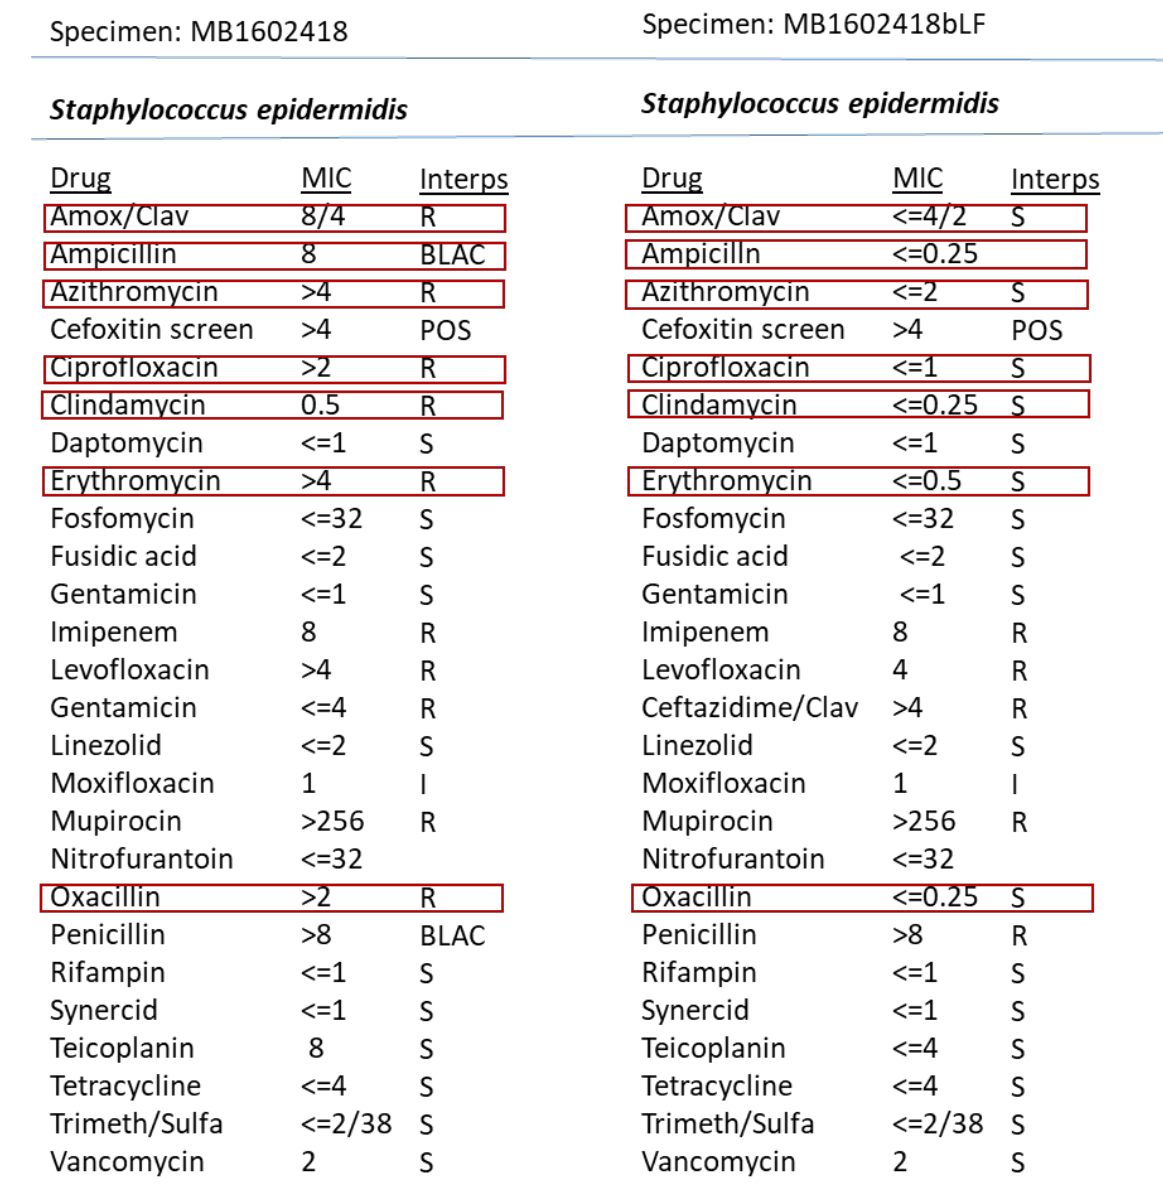
Figure 7. Demonstration of effect of bovine lactoferrin (bLF) on Methicillin resistant Staphylococcus epidermidis (MRSE)